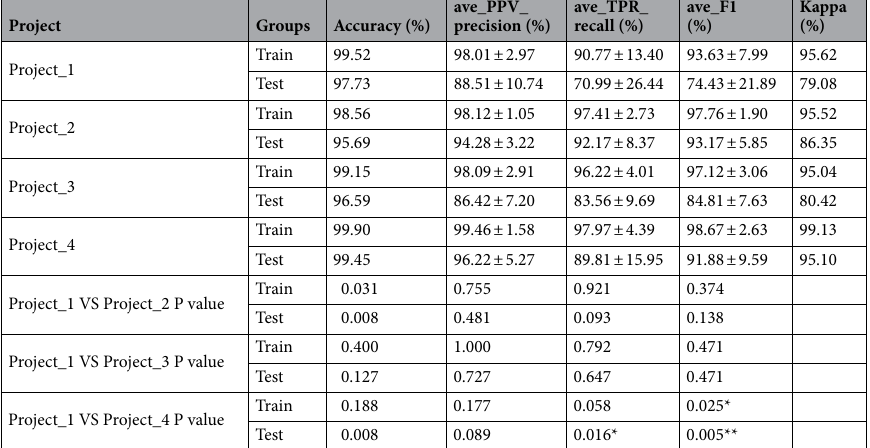
Table 2. Comparison of the identified results of projects by different categories. PPV positive predictive value, TPR true positive rate.